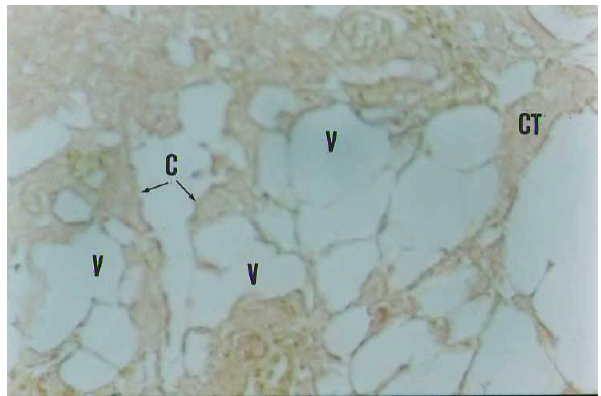
(Fig.20): Photo microscopic illustrates the various connective tissue stroma (CT). (Van —Giesson